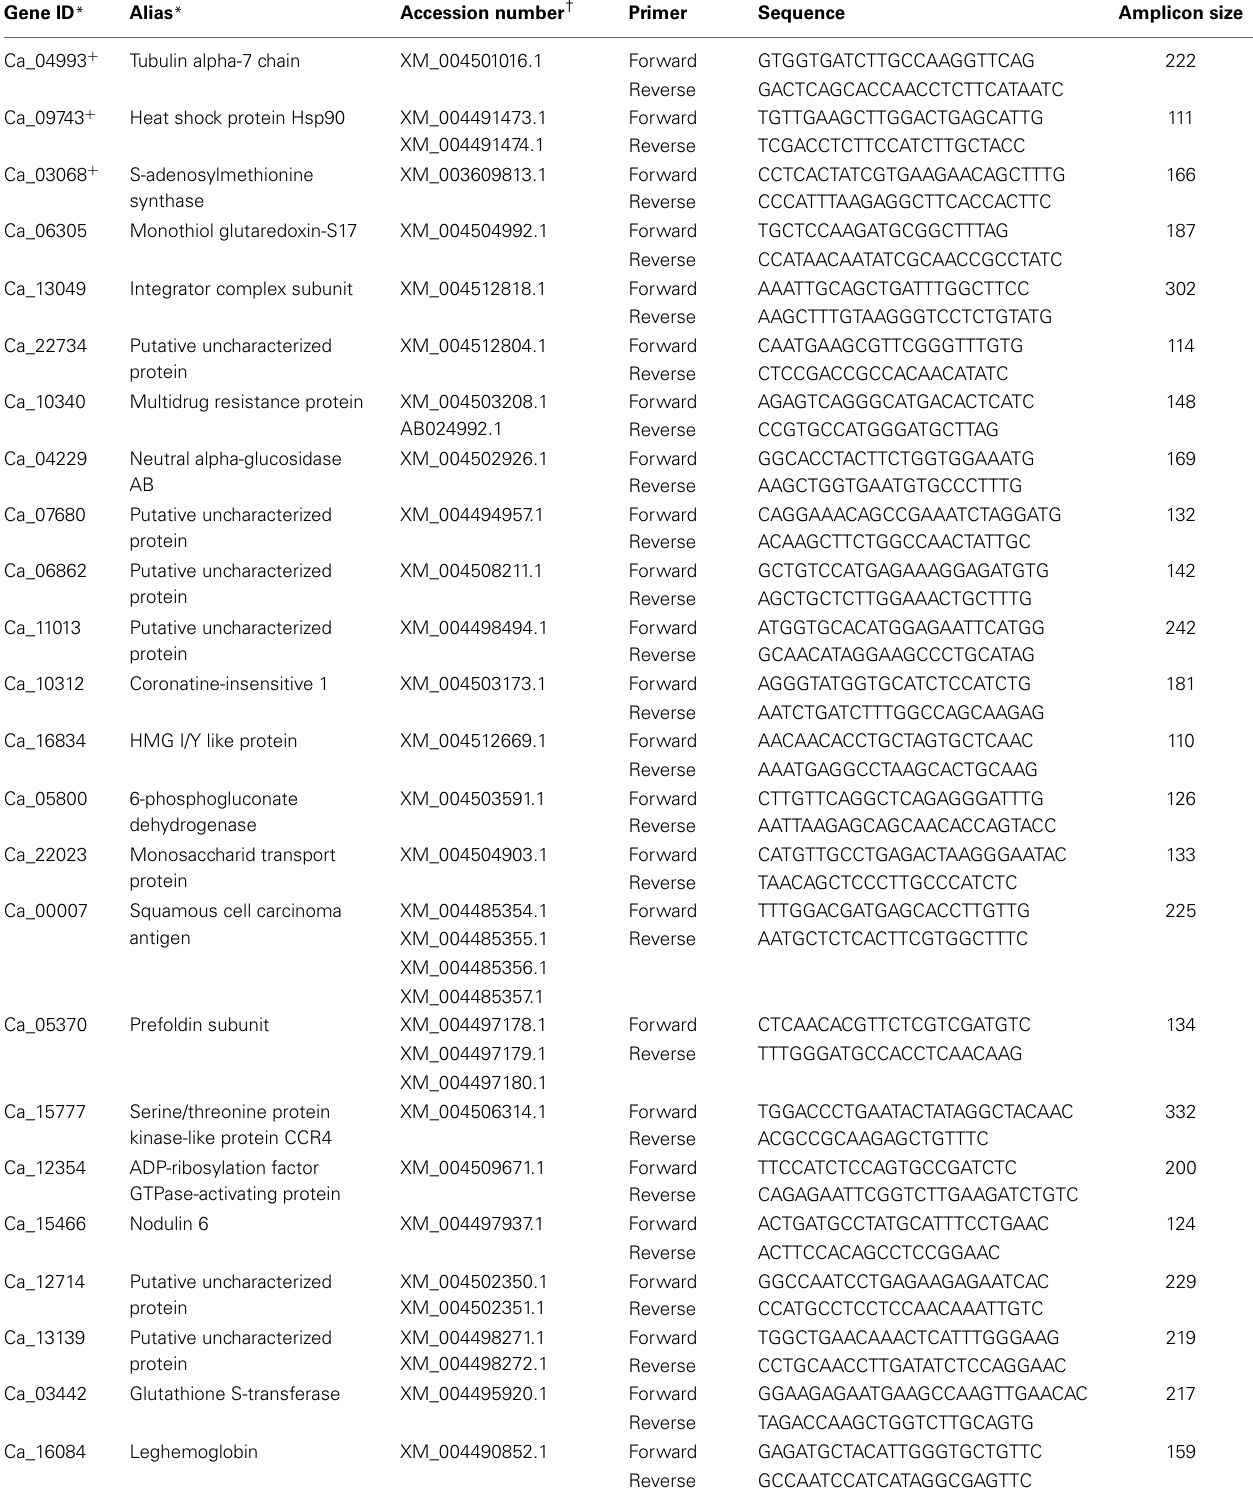
Table 1 | List of targeted mRNAs along with the respective primer and probe sequences used for qRT-PCR quantification. Gene ID